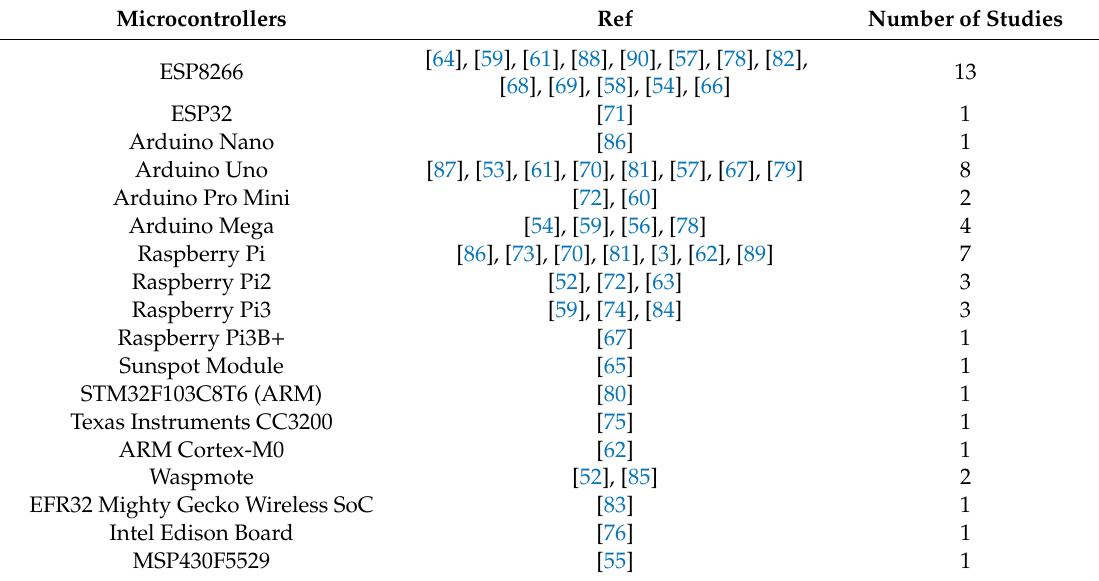
Table 4. Microcontrollers used to connect